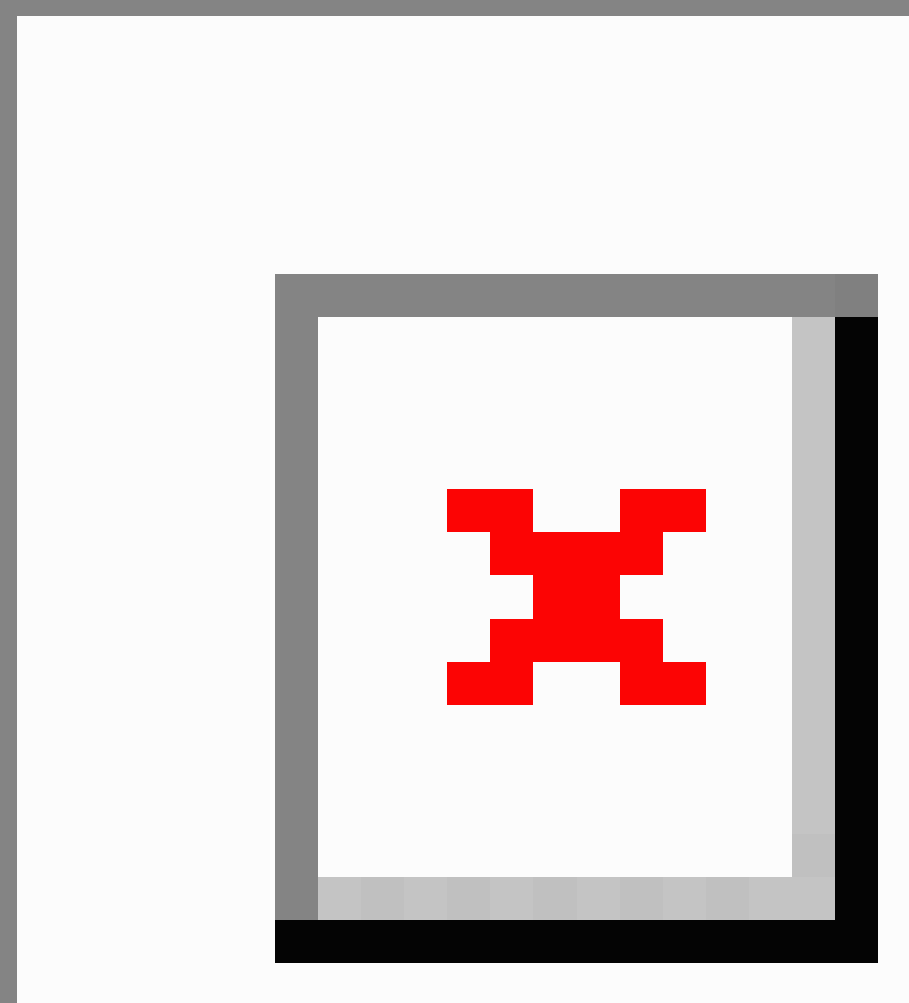
Figure 2. Glucose Buddy screenshots of the menu and adding a